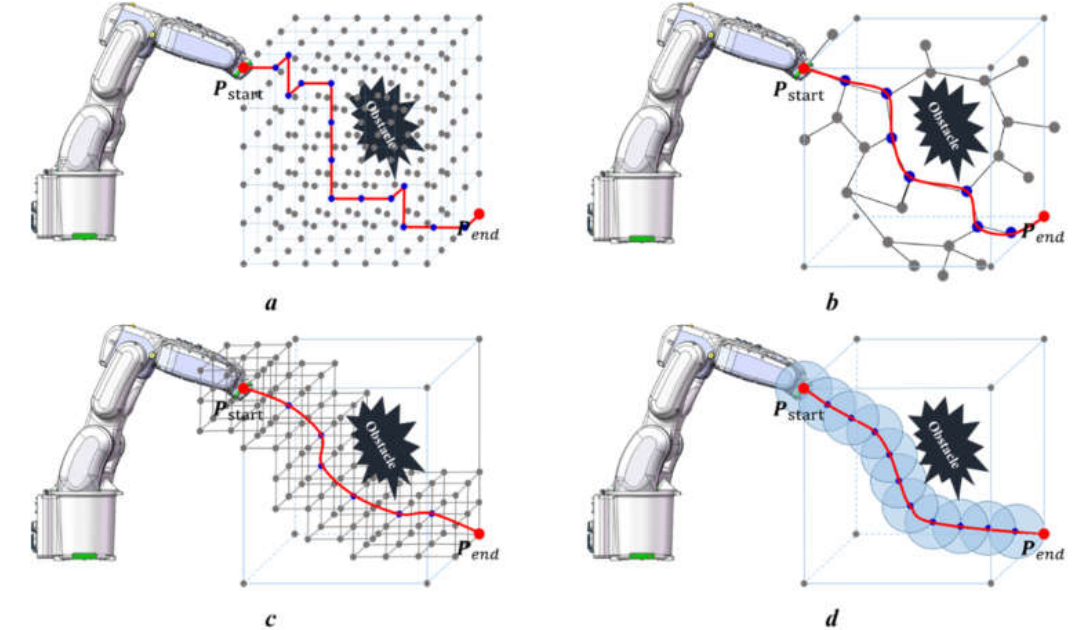
Figure 1. Schematic diagram of four different path-planning strategies for industrial manipulators. Picture ( a ) shows the planning strategy of map-based planning algorithms such as A*; Picture ( b ) shows the planning strategy of sampling-based planning algorithms such as RRT, PRM, and APF, etc.; Picture ( c ) is SbOSMS strategy which combines a map-based planning strategy and a sampling-based planning strategy to reduce both the search space and search time, as well as overcome the defect of random planning results for RRT; Picture ( d ) shows the proposal of this paper, which changes the node map in picture c into local-global sphere search space around EEF position point during every sampling period.